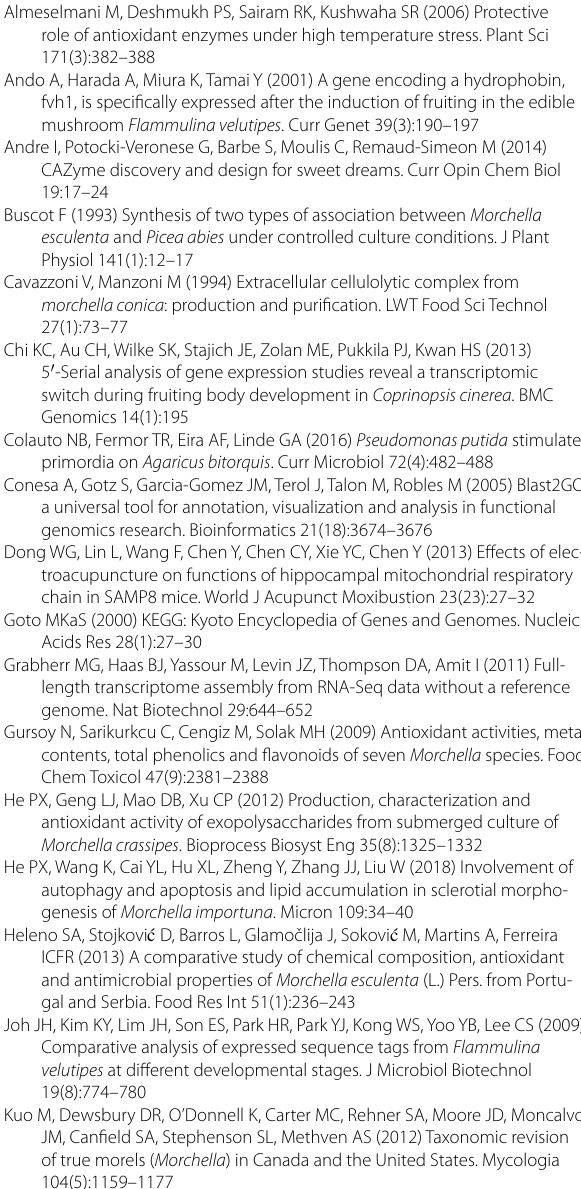
Additional file 1: Table S1 . Gene-specific primers used for qRT-PCR. Table S2. Number of open reading frames (ORFs). Table S3. Top 10 spe- cies distribution by unique species hits under NR annotation. Table S4. GO functional classification of DEGs. Figure S1. Histogram presentation of COG classification. Figure S2. GO functional classification of the whole transcriptome of M. importuna. Figure S3. Histogram presentation of KEGG pathway classification. Figure S4. GO functional enrichment analy- sis of the three clusters of DEGs. Figure S5. KEGG functional enrichment analysis of the top 30 significant